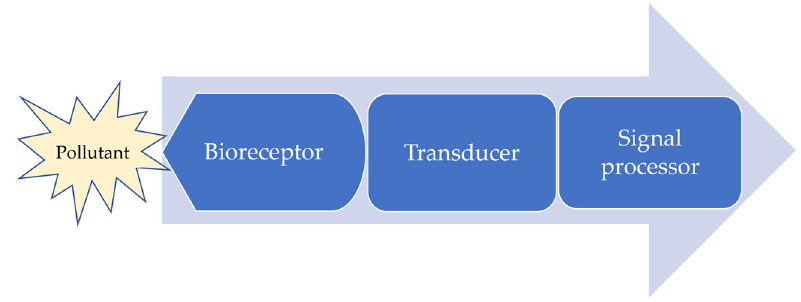
Figure 1. Operation of a